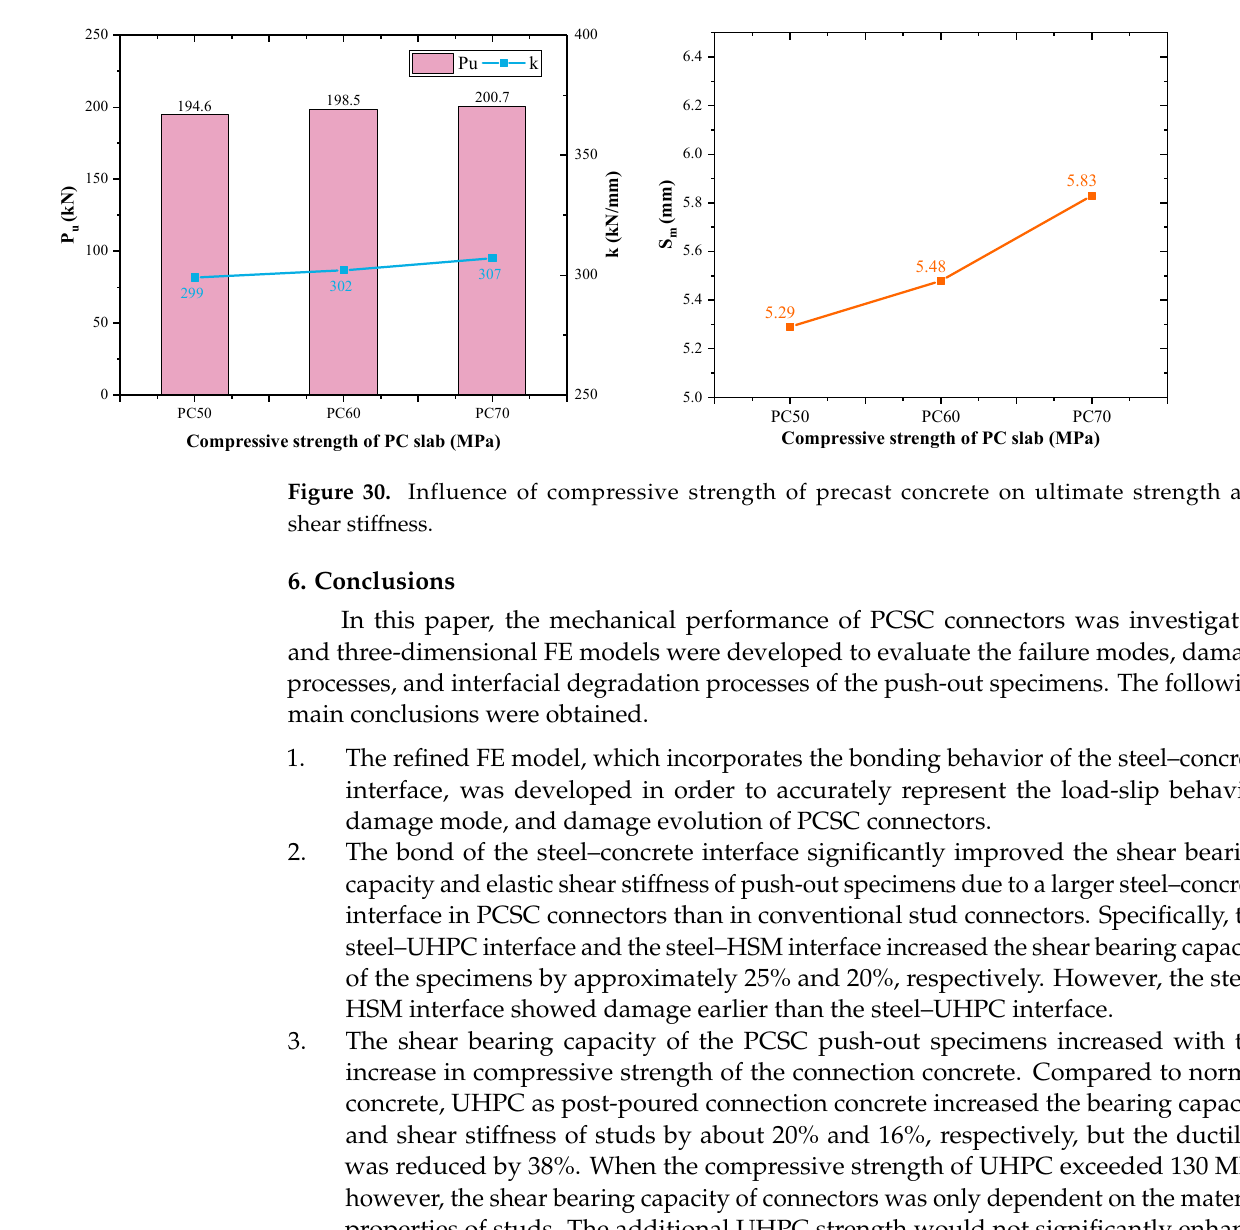
Figure 29. Load-slip curves of specimens with different compressive strength of precast concrete.